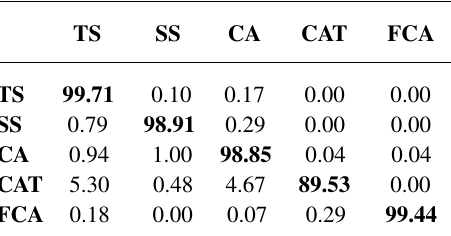
Table 8. Confusion matrix July 2018